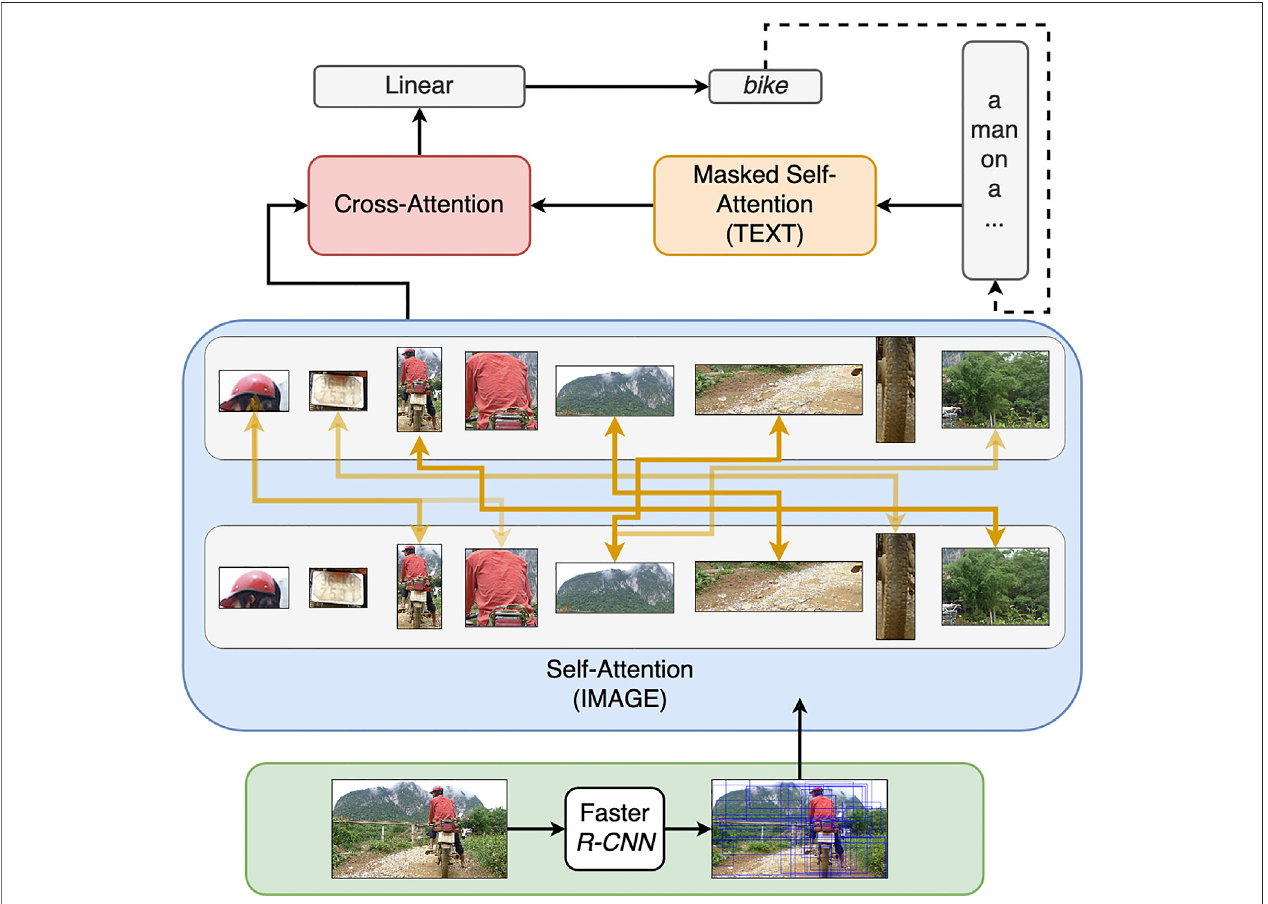
FIGURE 1 | The architecture of the multi-modal transformer and a detailed visualisation of its image encoder (visual self-attention). The model consists of three parts: self-attention on visual information, masked self-attention on textual input and cross-attention, which learns multi-modal fusion. The predicted word is concatenated with the previously generated words and passed as the new input to the masked self-attention. The image encoder takes (i) visual representations of objects produced by a pre-trained faster R-CNN and (ii) geometric representations between detected objects. The self-attention operates at the level of detected imageobjects,buildingattentionlinksofvariousstrengthbetweenthem.Theintensityoftheorangelinesindicatestheintensityoftheattentionlinksbetweenobjects.The attention links are created by every attention head in all layers of the image encoder and, if present, can vary in terms of attention